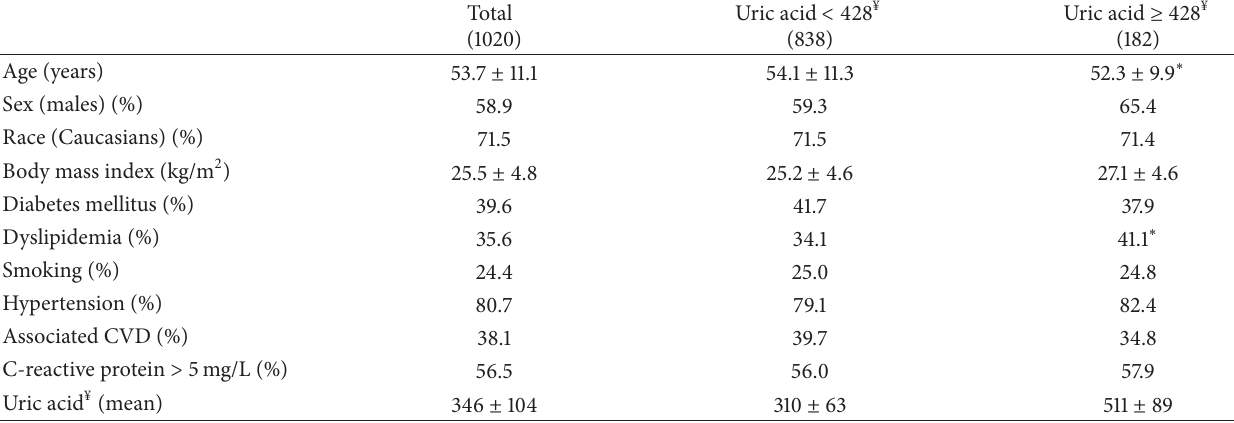
Table 1: Main characteristics of hemodialysis patients on the waiting list for renal transplantation.